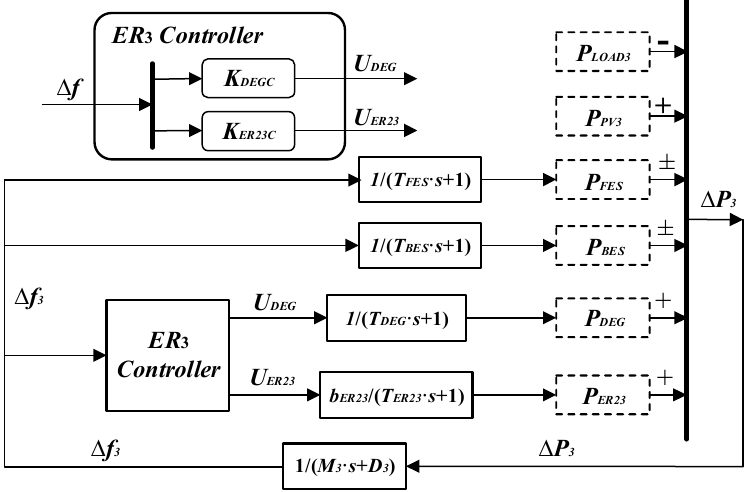
Figure 4. The linearized block diagram of the third microgrid ( MG ) .